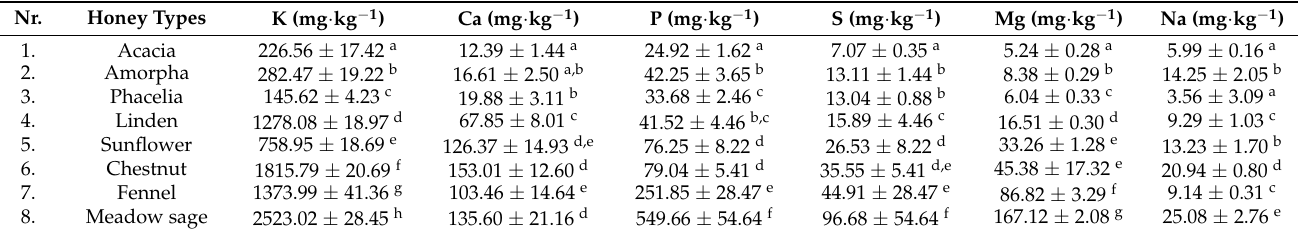
Table 3. Macroelement content of the studied honey samples.